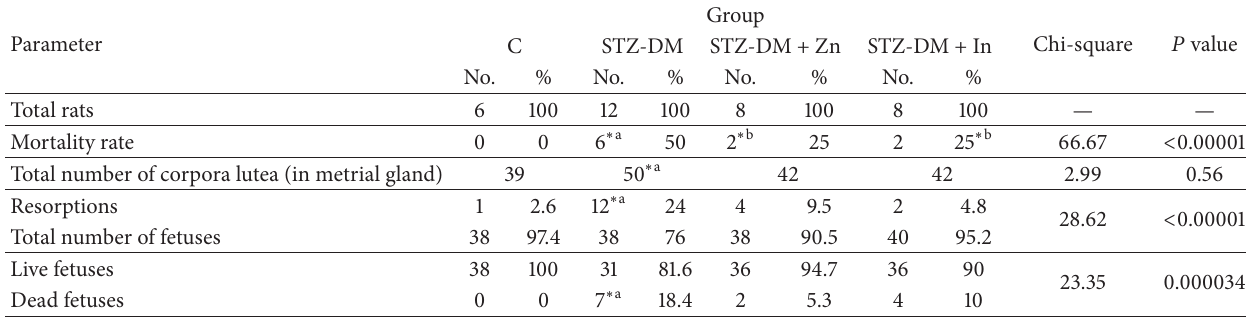
Table 2: Pregnancy outcome and embryolethality in the different